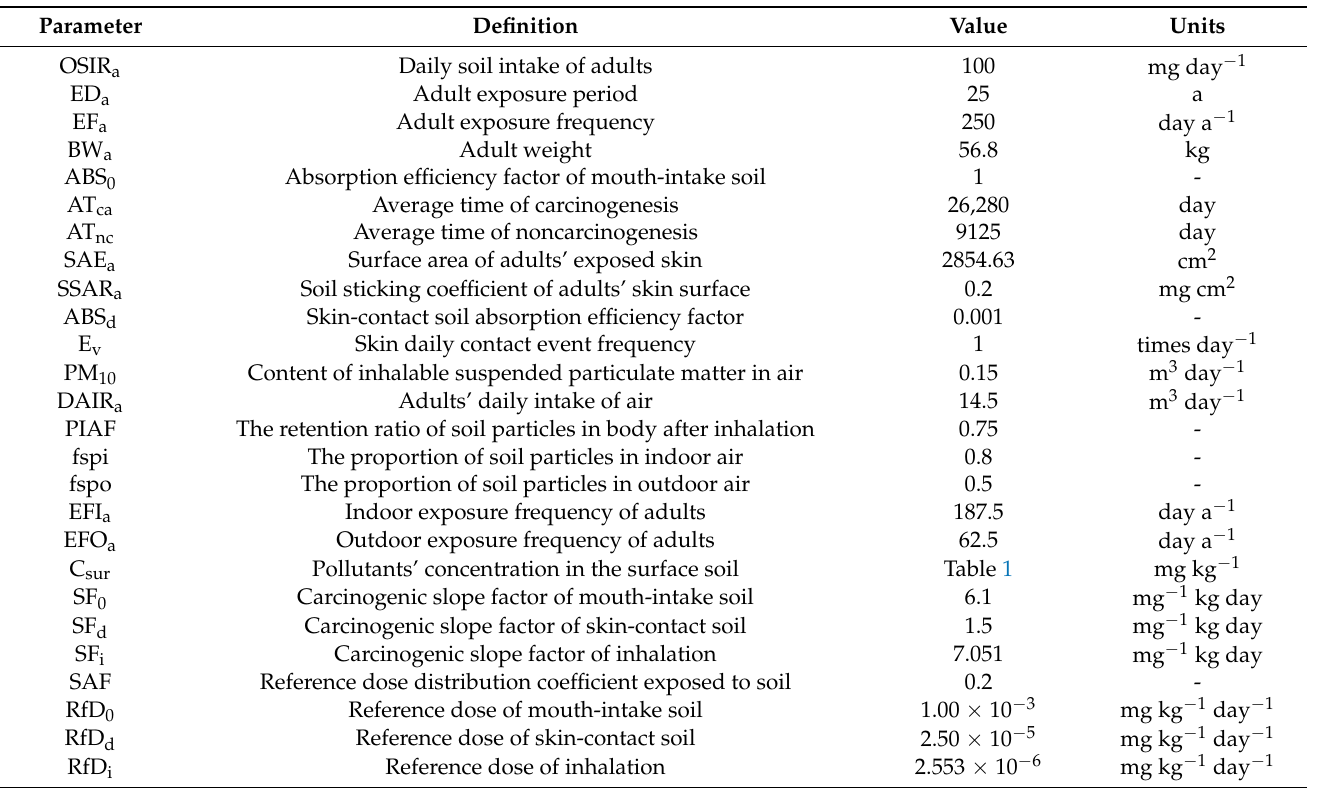
Table 2. Major parameters in the models for calculating exposure doses.